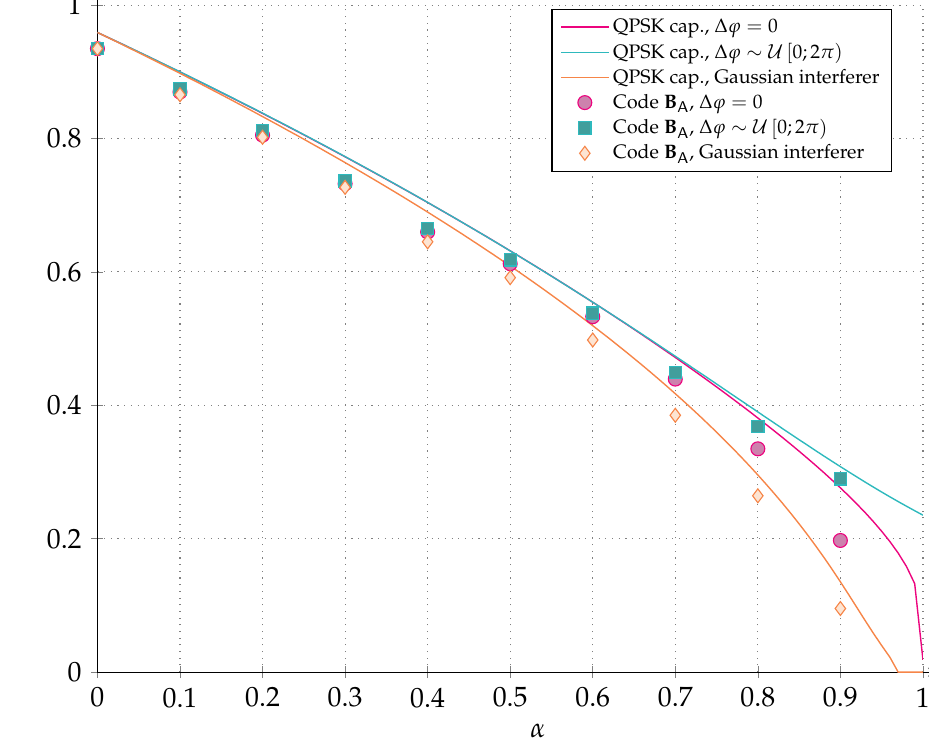
Figure 7. The noise threshold for the code ensemble described by the base matrix B A , calculated using quantized density evolution, compared to capacity, on a QPSK channel with a single equal power interferer as the interferer overlap, α , is varied. Three different models for the interferer are considered, a time- and phase-aligned QPSK signal, a time-aligned and random phase QPSK signal and a Gaussian